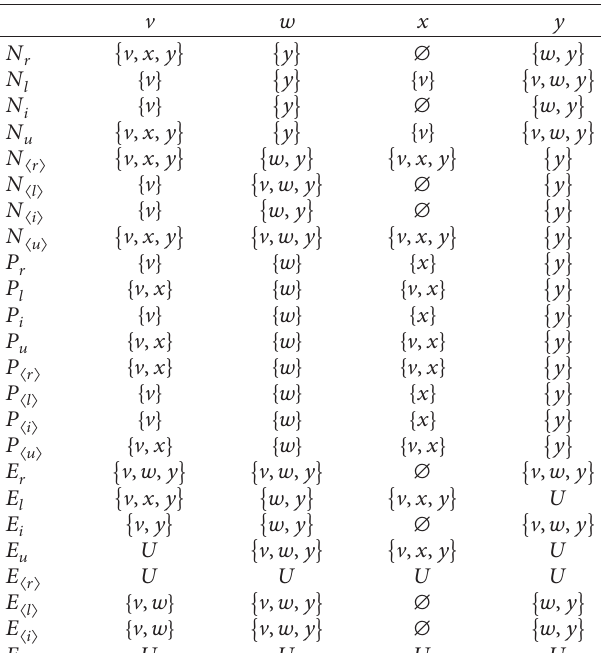
Table 1: j -neighborhoods and E